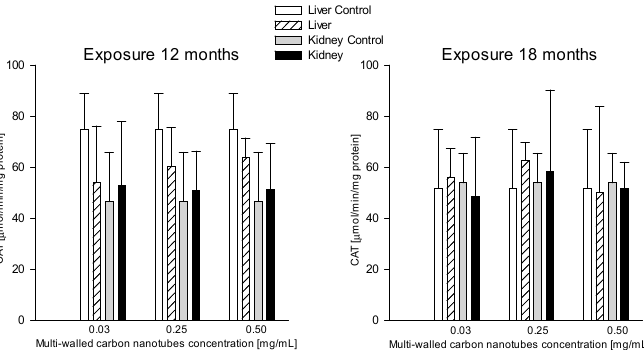
Figure 10. Comparison of catalase (CAT) concentrations in the liver and kidneys of animals exposed to multi-walled carbon nanotubes for 12 and 18 months.